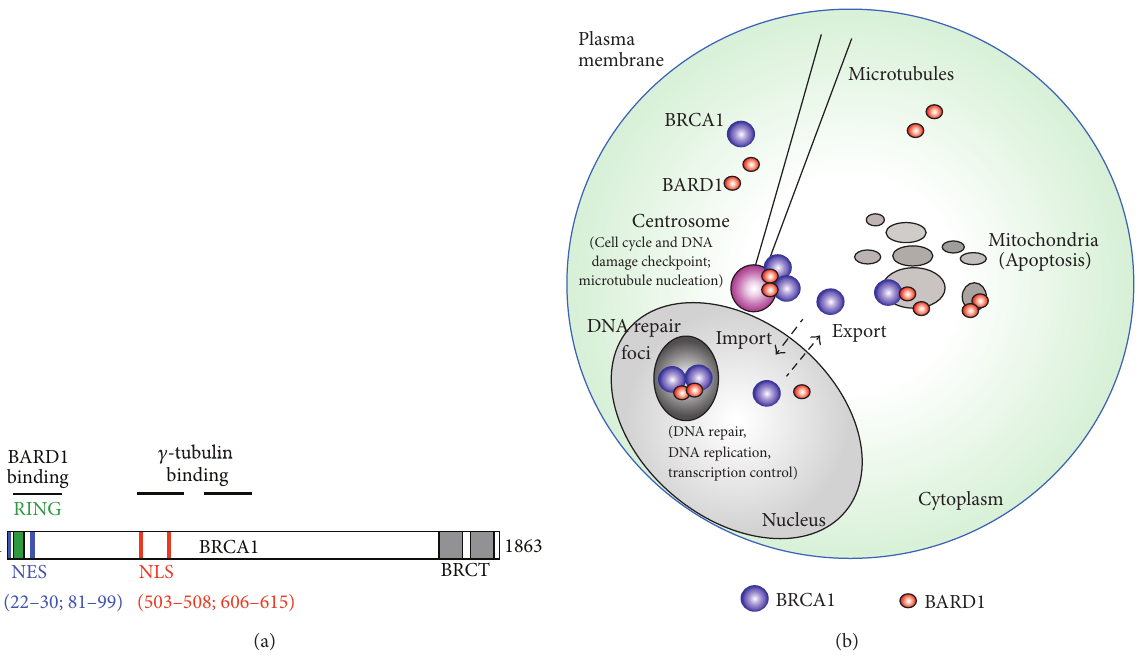
F 1: BRCA1 domain structure and subcellular transport pathways. (a) Protein domain structure of BRCA1 showing the location of nuclear localization signals (NLSs), nuclear export signals (NESs), and binding sites for BARD1 and gamma-tubulin. e RING and BRCT protein interaction domains are shown at the amino and carboxy termini, respectively. (b) Diagram summarizing the distribution and movement of BRCA1 in the cell. Once translated in the cytoplasm, BRCA1 can move to the centrosome where it dimerizes with BARD1 to ubiquitinate proteins such as gamma-tubulin that regulate centrosome duplication and microtubule nucleation, or to the mitochondria where it is implicated in cell survival and/or apoptosis regulation. BRCA1 enters the nucleus through the importin-alpha/beta pathway and locates at nuclear DNA replication sites. In response to DNA damage, BRCA1 is sequestered (as a dimer with BARD1) to different types of DNA repair complexes at foci. e interaction with BARD1 tends to trap BRCA1 in the nucleus through the masking of its NES. If BRCA1 is not bound to BARD1, it is exported to the cytoplasm by the CRM1 export receptor, and this has been linked to the roles of BRCA1 in apoptosis and in centrosome duplication as revealed by functional comparison of wild-type and NES-mutated forms of